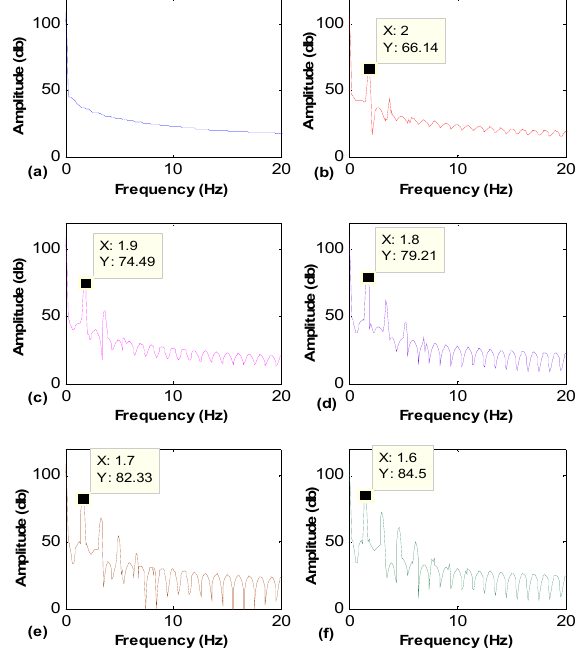
Figure 13. Park’s vector spectra of stator current at nominal load and under different degrees of fault conditions: ( a ) healthy motor, ( b ) under 1% degree of fault, ( c ) under 2% degree of fault, ( d ) under 3% degree of fault, ( e ) under 4% degree of fault, and ( f ) under 5% degree of fault. Table 4. Amplitudes and frequencies of the 2 · s · f s spectral components at nominal load and under different degrees of rotor fault conditions.